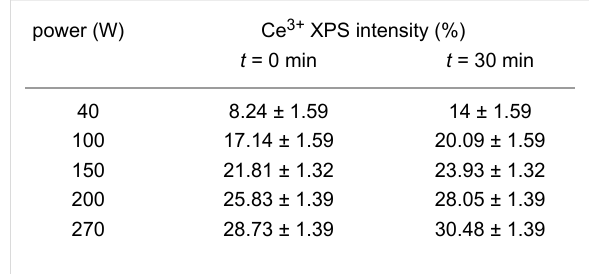
Table 1: Ce 3+ XPS intensity resulting from the fitting of the XPS spectra acquired at different X-ray power after different irradiation